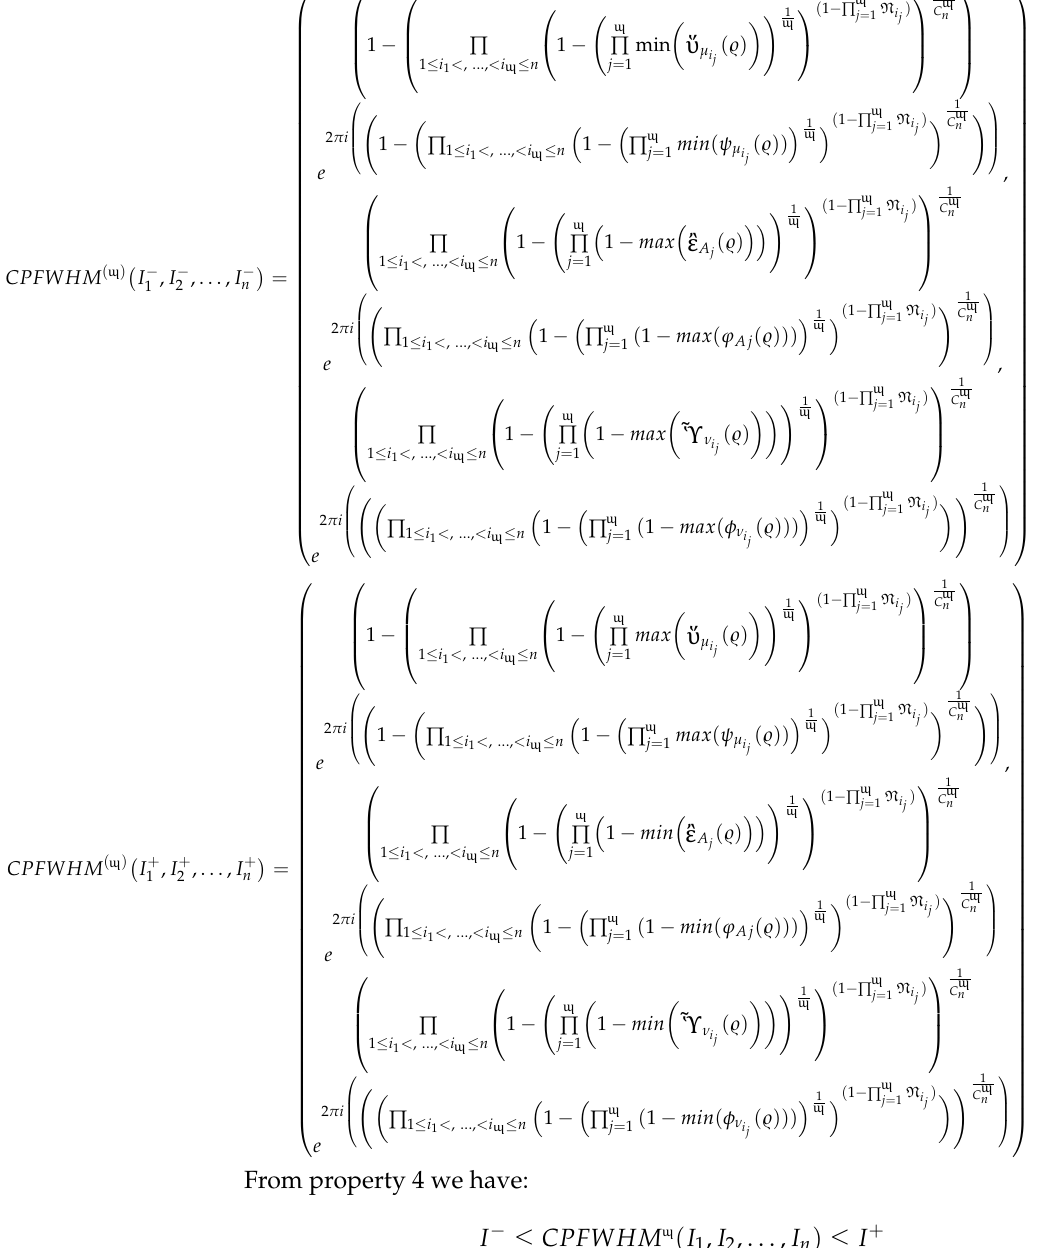
Table 1. Symbols and their